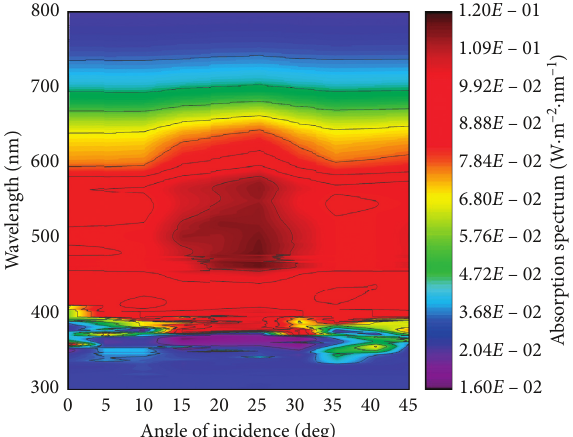
Figure 16: Map of the absorption in the OSC with arrangement of nanoantennas versus wavelength ( λ ) and incidence angles ( θ ).